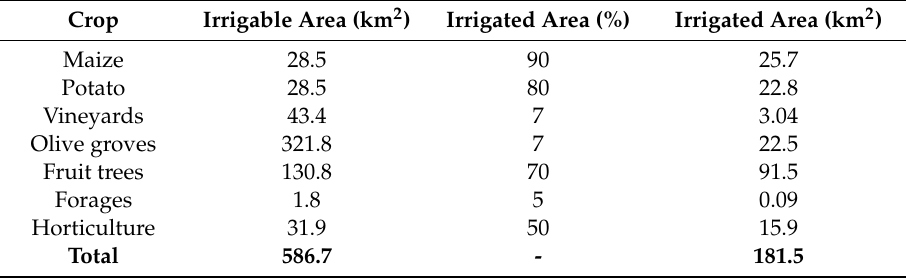
Table 2. The crops that were identified in the Sabor River Basin and their irrigable area and irrigated area according to agricultural census of 1999.